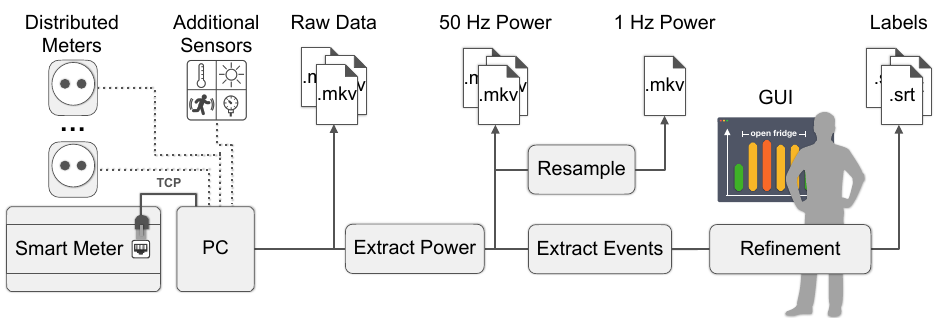
Figure 1. Overall flow of the presented framework to record advanced NILM